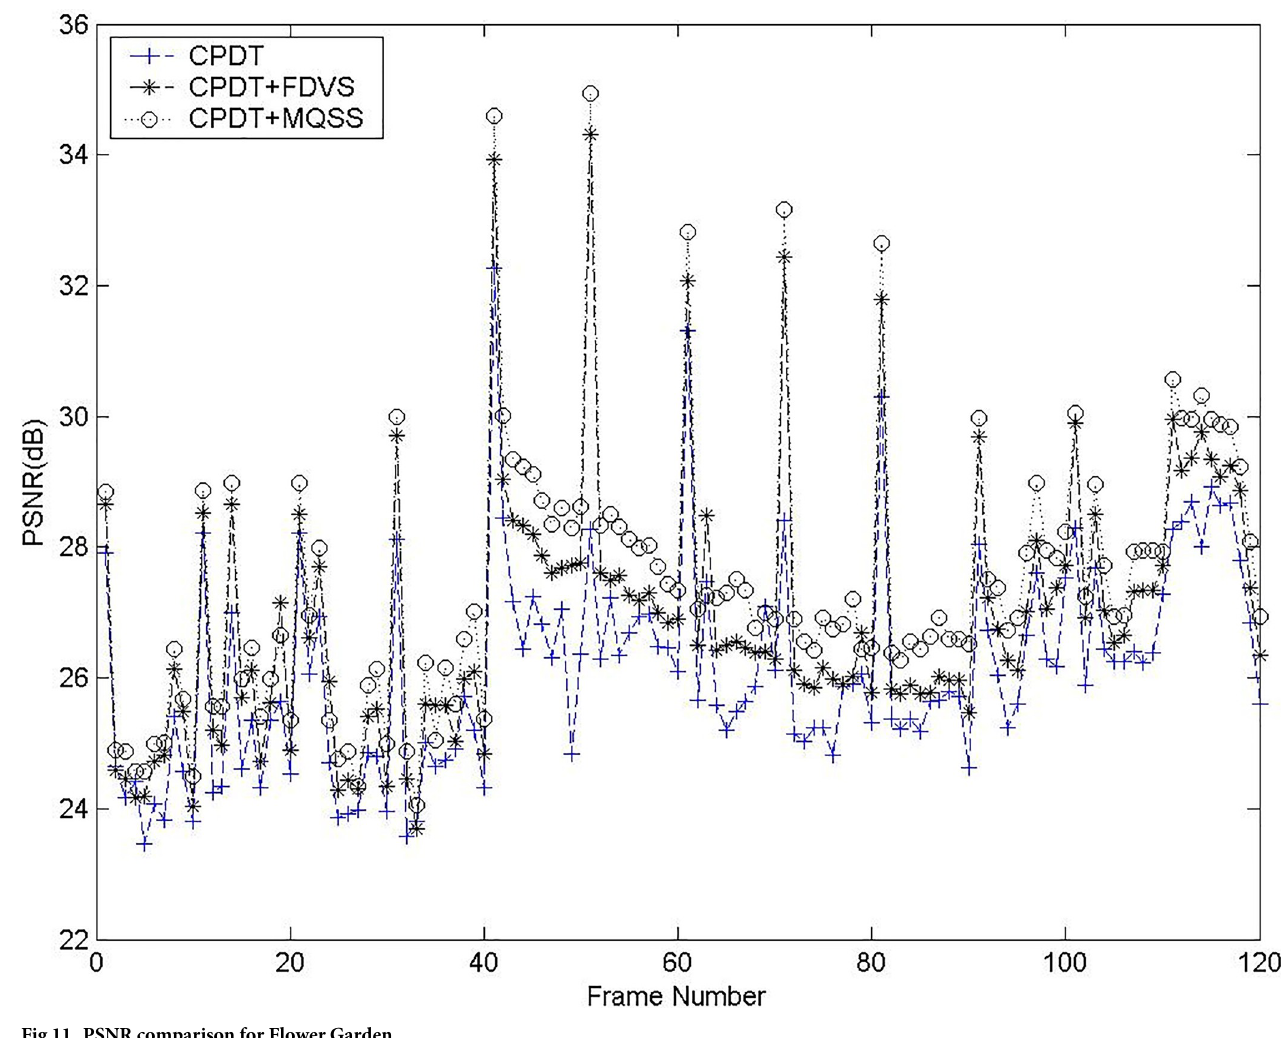
Fig 11. PSNR comparison for Flower Garden.